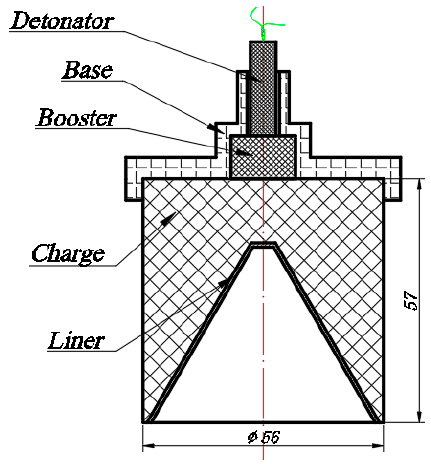
Figure 3. Structure of the 56 mm caliber shaped charge.